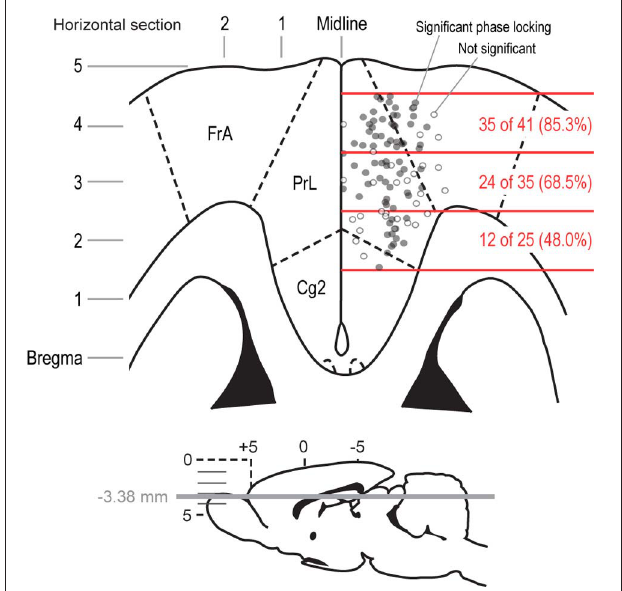
FIGURE 8 | Anatomical distribution of field potentials that showed significant phase locking around bouts of licks. A horizontal section is shown to depict the locations of the recording sites for the field potentials that were analyzed in the delayed alternation and variable-interval tasks. The section represents the mPFC at a depth of 3.38mm below the skull surface. Electrodes that had fields with significant phase locking at the initiation of licking are shown as filled gray dots. Electrodes that showed non-significant phase locking are shown as empty gray dots. The rostral-to-caudal span of the distribution of recording sites was split into three parts, which covered the peri-genual mPFC (caudal), the caudal prelimbic and adjacent agranular cortex (middle), and the rostral prelimbic and adjacent agranular cortex (rostral). The fractions of fields in these three regions that showed significant phase locking at the initiation of licking were significantly different by a Chi-square test ( p < 0 . 001). That is, most sites in the rostral mPFC showed phase locking when rats emitted bouts of licks, and fewer sites in the middle and caudal mPFC showed such phase